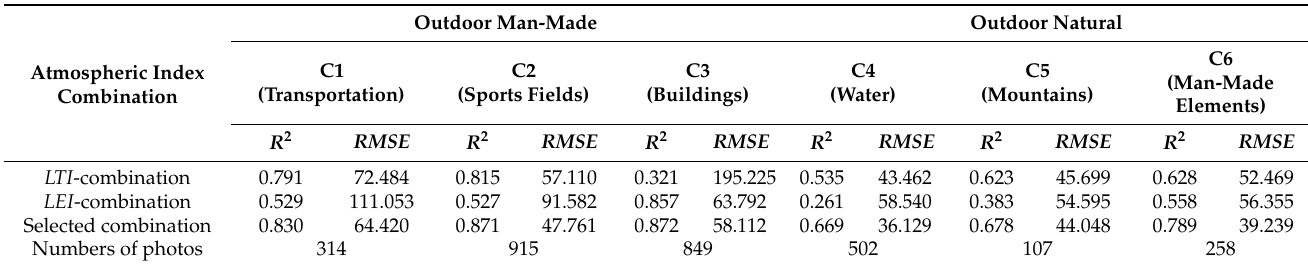
Table 1. The model performance under different scene